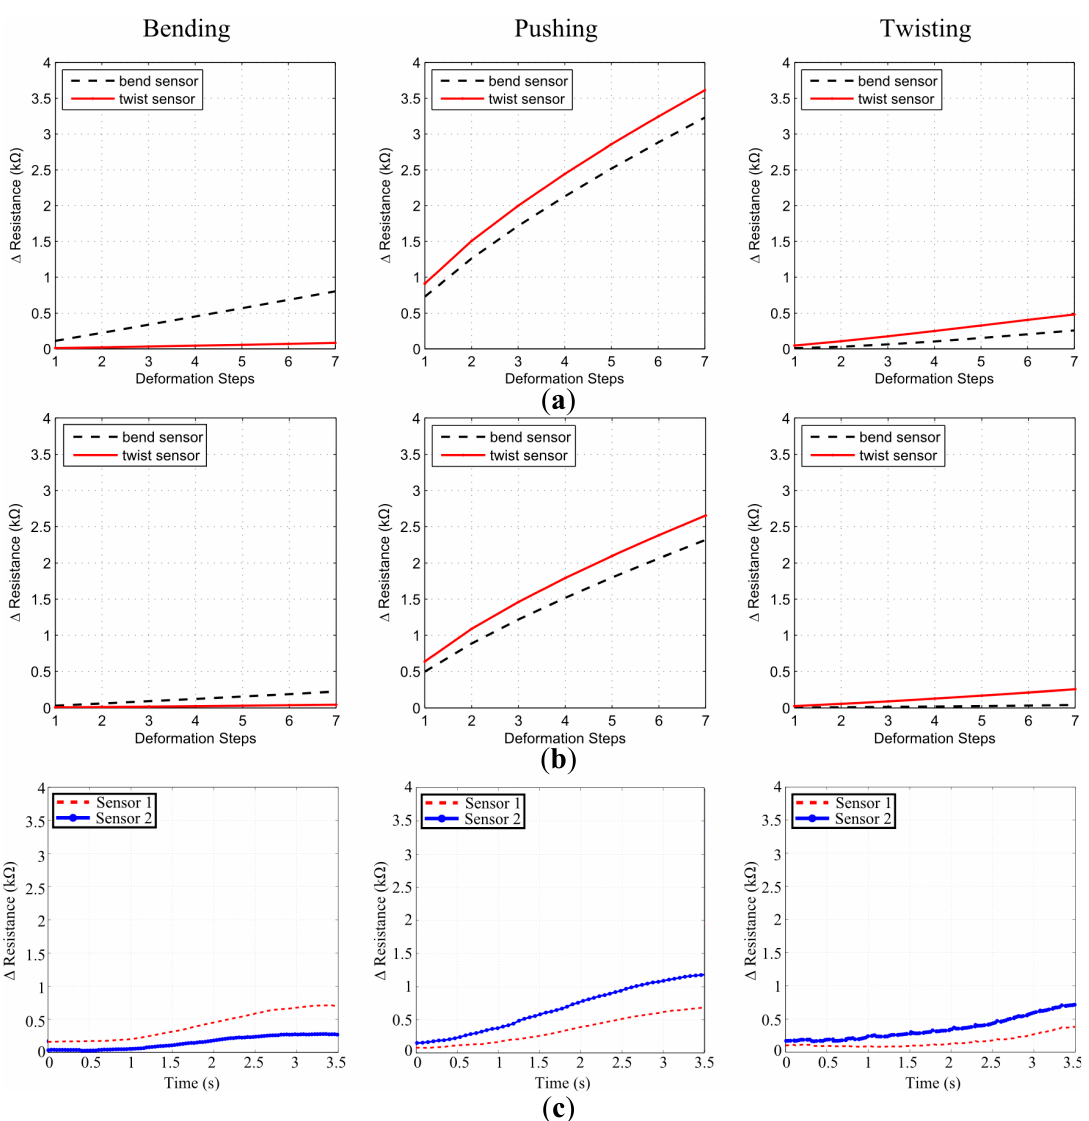
Figure 8. Case study on posture discrimination: twist, bend and push patterns.